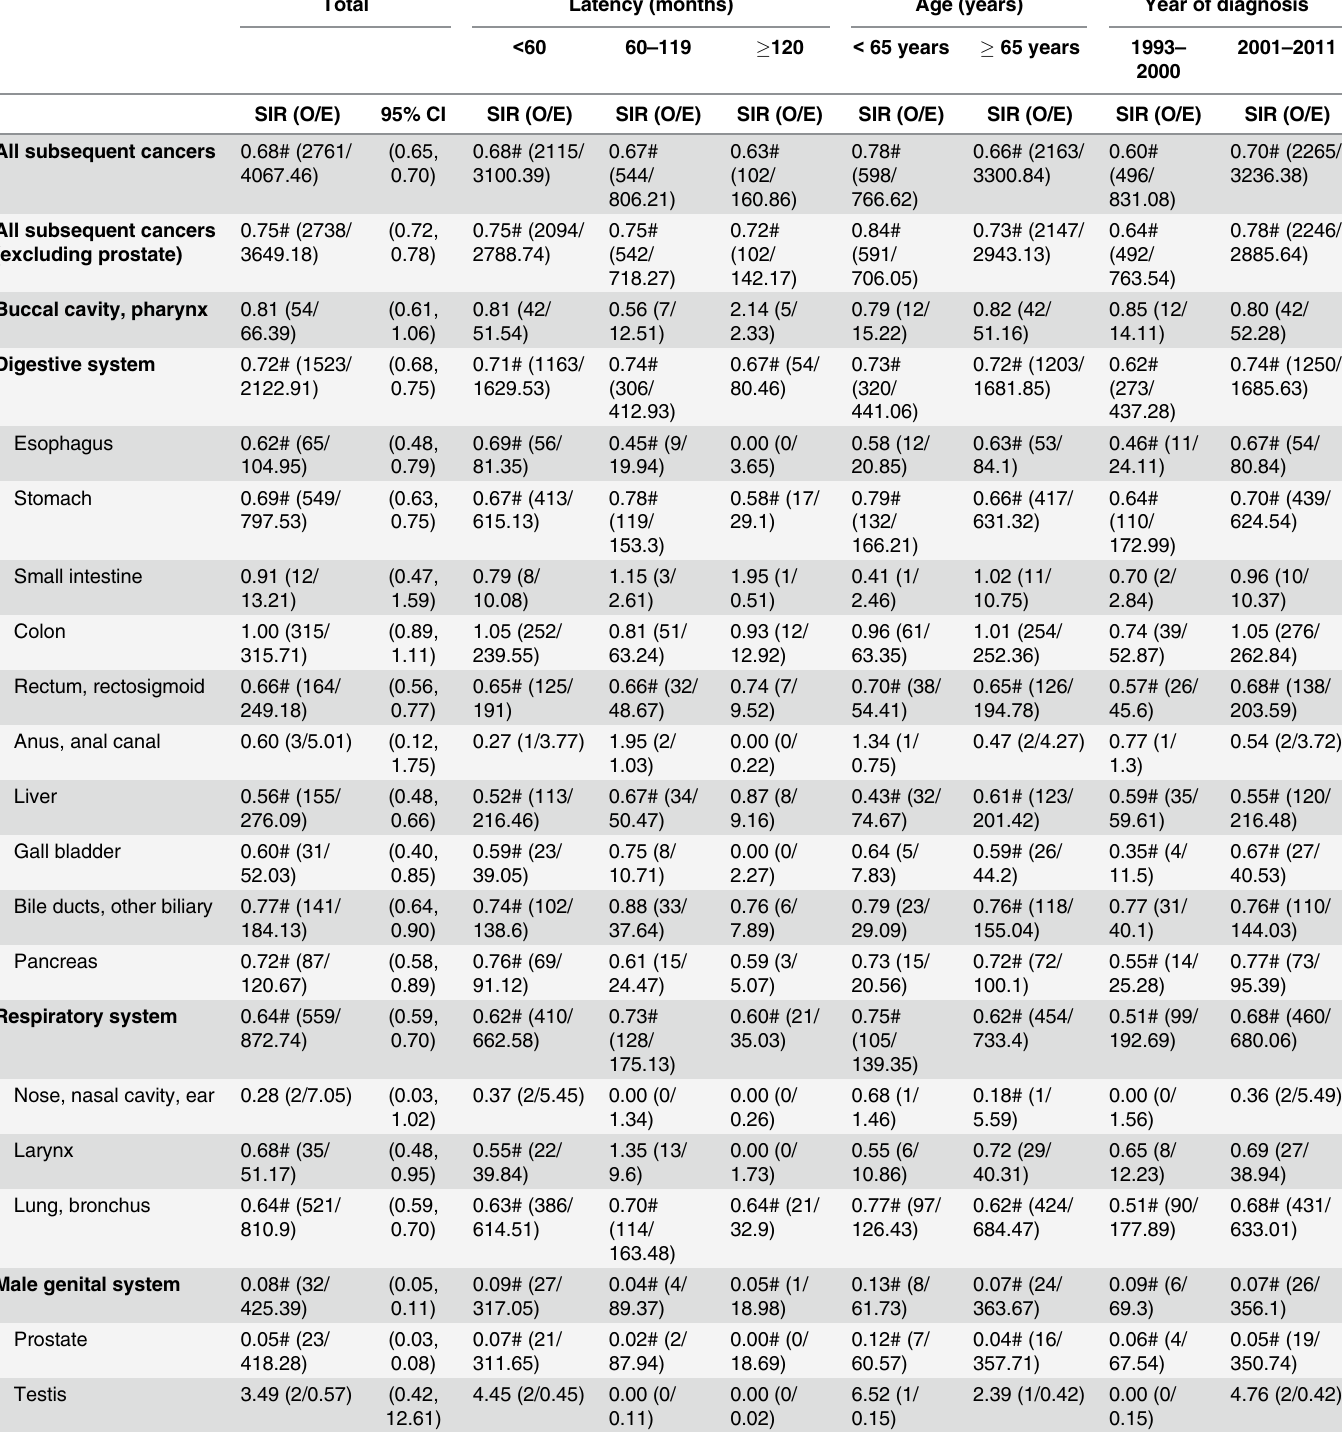
Table 2. Risk of subsequent primary cancers by latency, age, and year of diagnosis following cancer of the prostate diagnosed between 1993 and